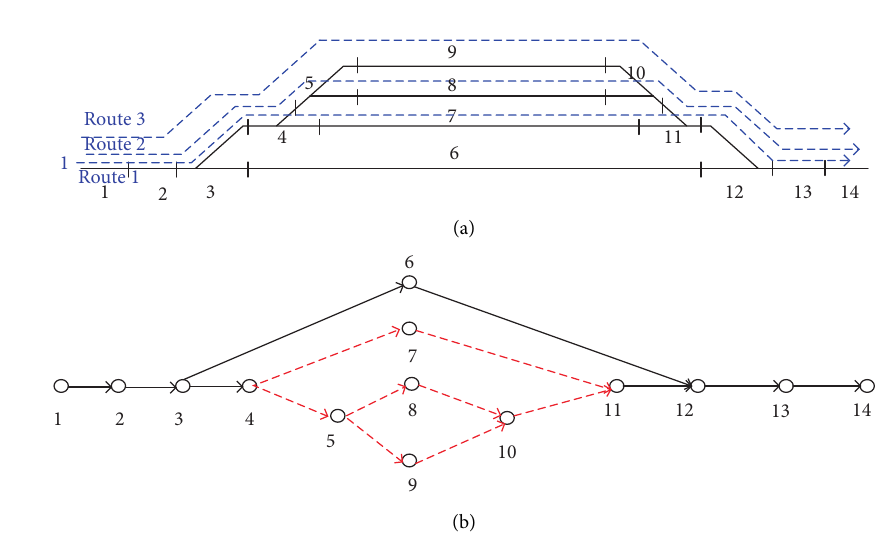
Figure 5: Alternative routes for one train in a railway station